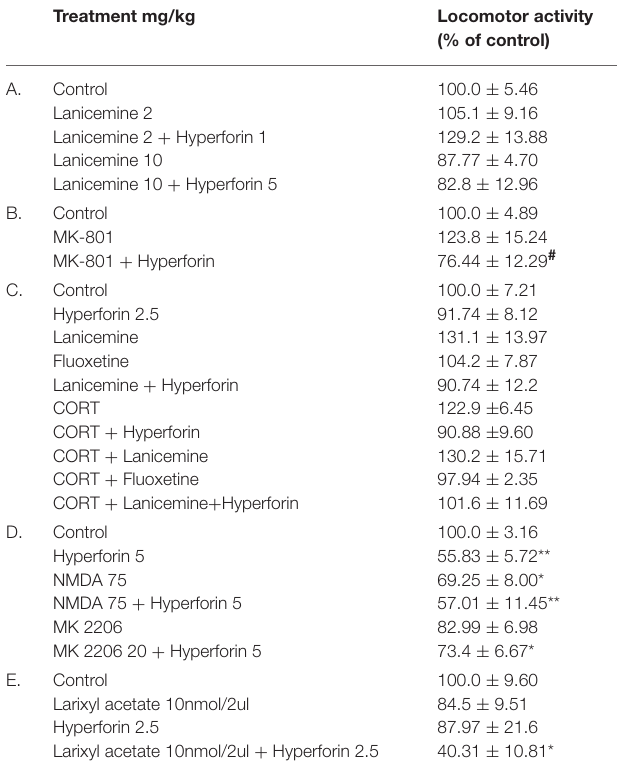
TABLE 2 | The effect of used compounds and procedures on the locomotor activity of mice. Treatment mg/kg Locomotor activity